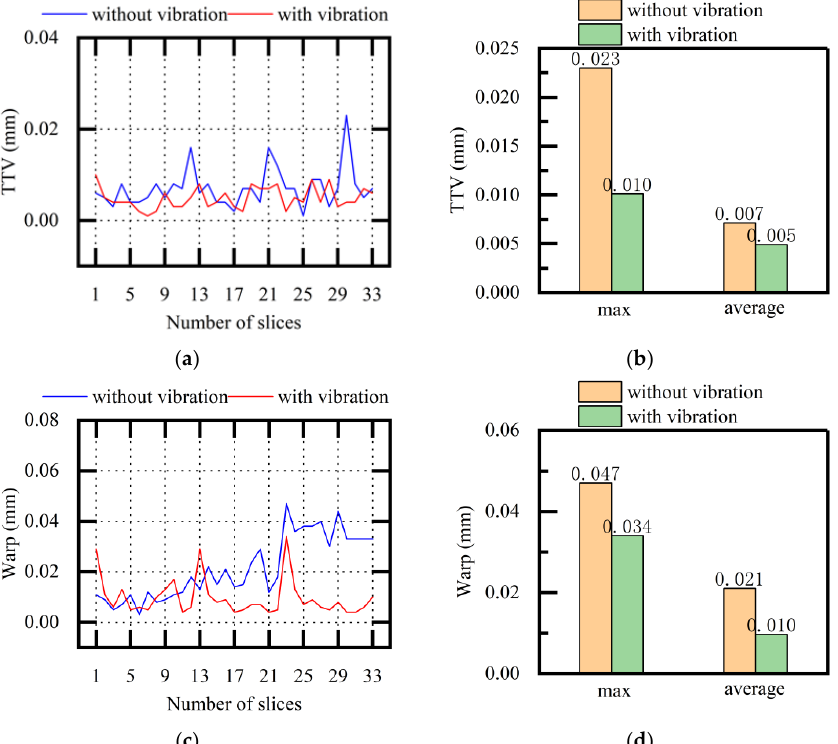
Micromachines 2022 , 13 , x FOR PEER REVIEW 17 of 19